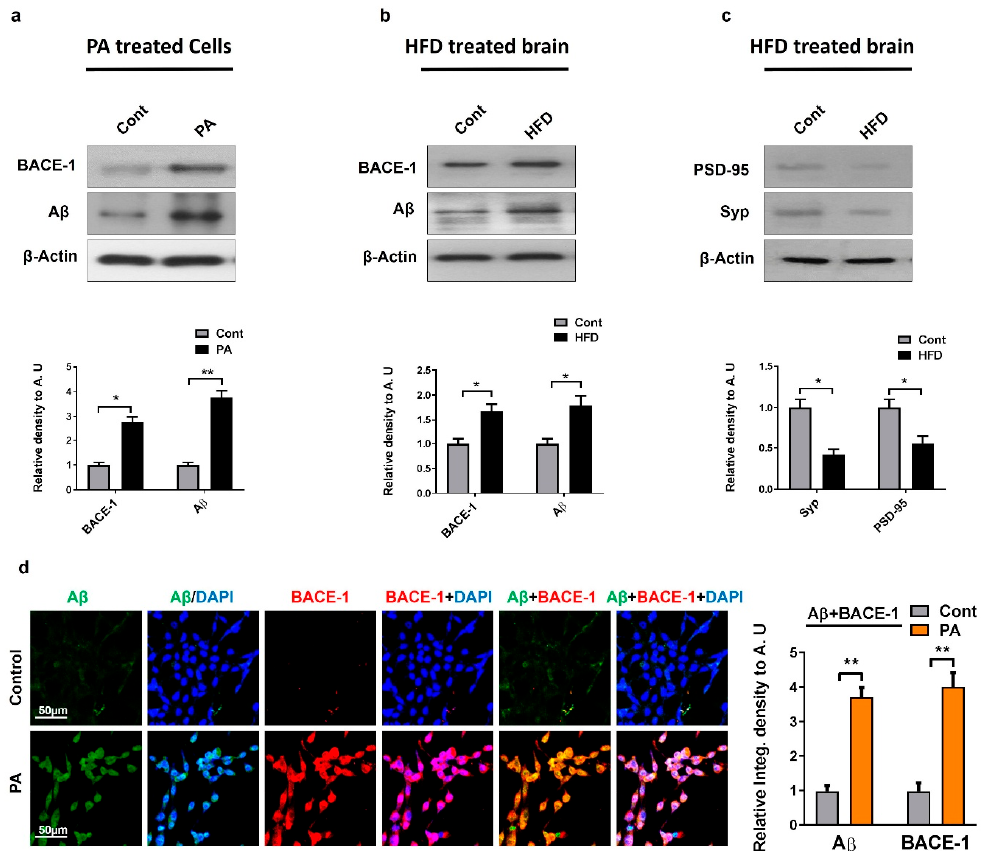
Figure 5. Metabolic dysfunction induced AD-like pathology both in in vivo and in vitro model: ( a , b ) The expression levels of A β and BACE-1 were assessed by Western blot in palmitic acid-treated HT22 cells, and in HFD mice. β -actin was used as a loading control. For protein band quantification Image J software was used. One-way ANOVA followed by post-hoc analysis was used for statistical analysis. The density values were expressed in arbitrary units (AUs) as the mean ± SEM; ( c ) the expression level of neuronal synapse proteins (both pre-synapse, i.e., Synaptophysin and post-synapse density protein 95, i.e., PSD95) along with their respective histograms were analyzed through Western blot in the HFD-fed mice brain; ( d ) given are the representative images of double immunofluorescence staining of A β and BACE-1in Palmitic acid treated HT22 cells. The data are expressed as the mean ± SEM. * p < 0.05, ** p <